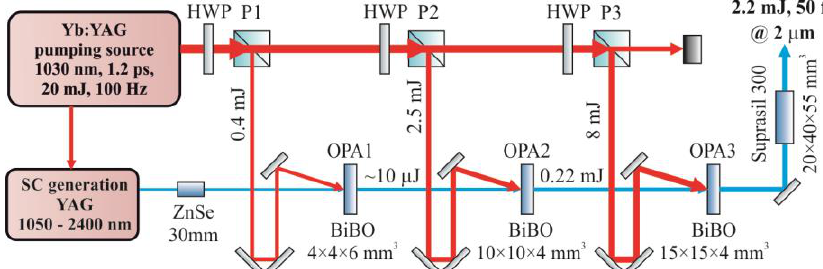
Fig. 1 Experimental layout of SC amplification in three OPCPA stages based on BiBO crystals: P1, P2, P3 –polarizing cubes, HWP – half wave plate, ZnSe– zinc selenide